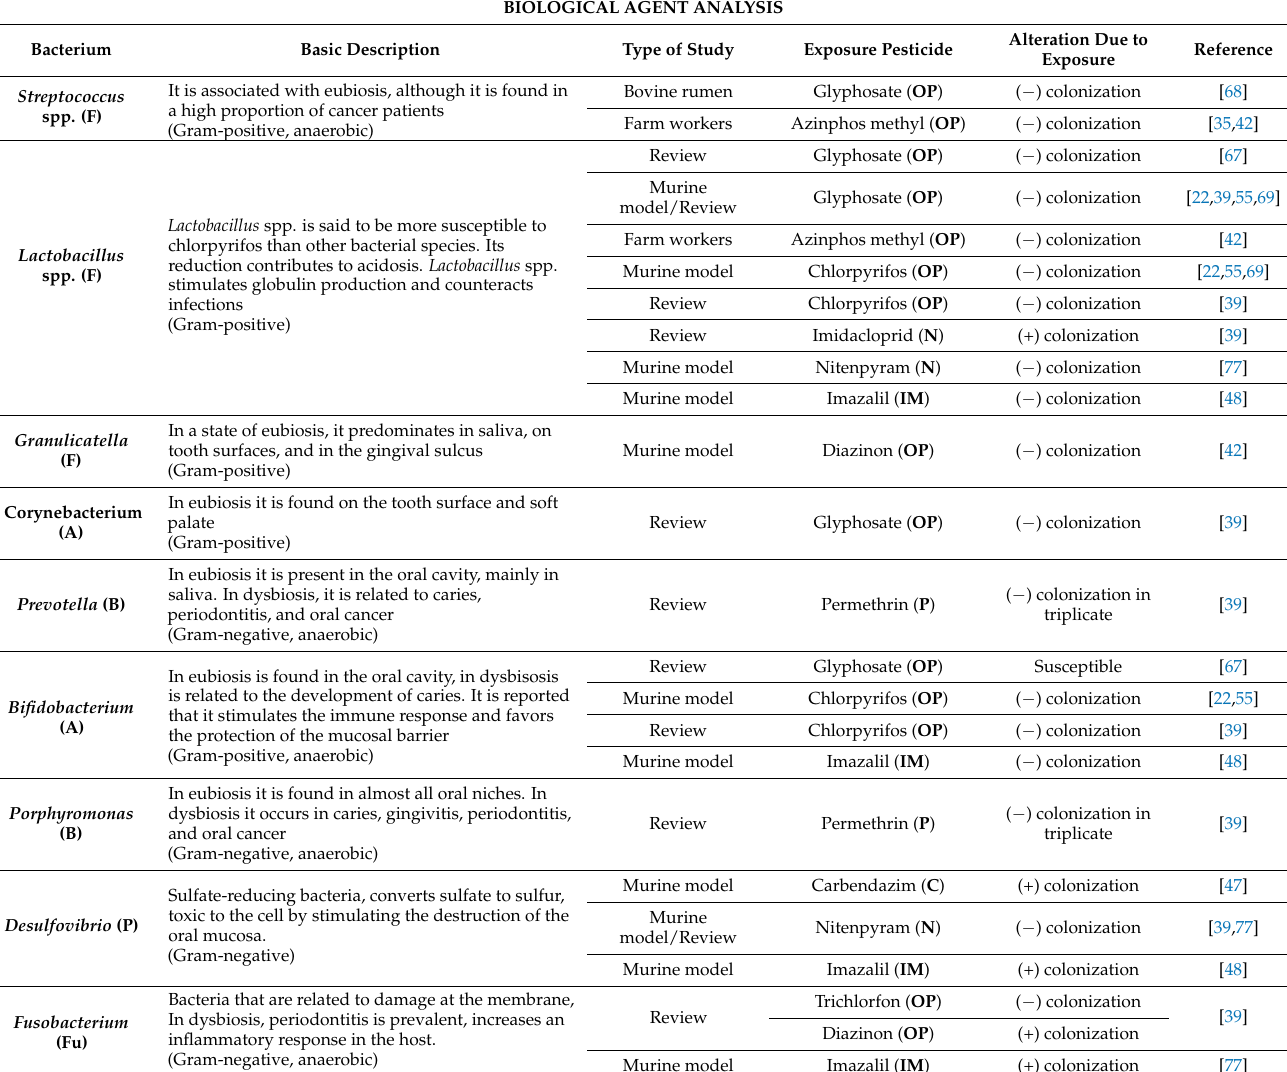
Table 4. Effect of pesticides on bacteria and